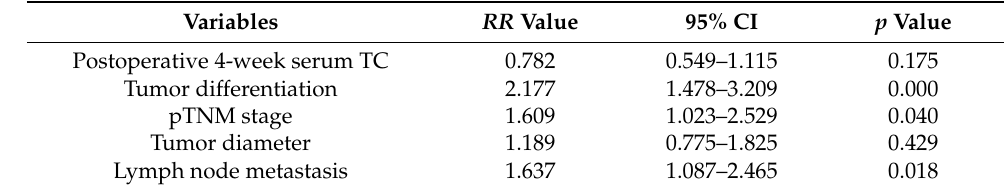
Table 6. Multivariate analysis of postoperative tumor recurrence in pancreatic cancer